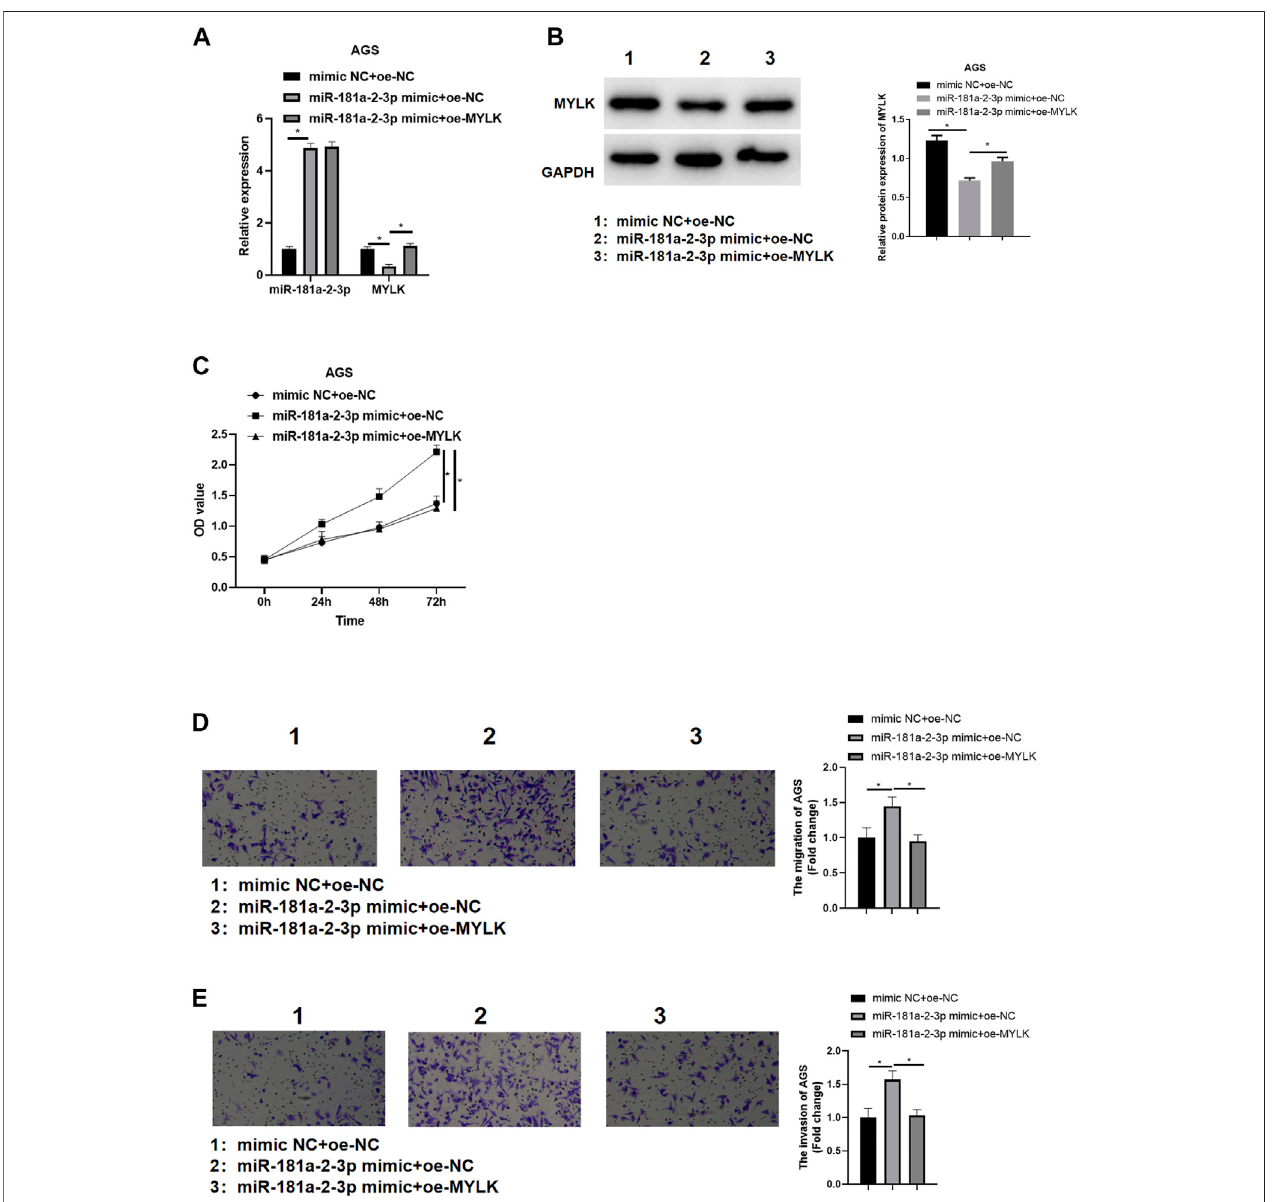
FIGURE 5 | miR-181a-2-3p promotes GC cell progression via hampering MYLK miR-181a-2-3p and MYLK were simultaneously overexpressed in AGS cells; (A) qRT-PCR and (B) western blot examined miR-181a-2-3p and MYLK; CCK-8 and Transwell (100 × ) determined cell (C) viability, (D) migration and (E) invasion of AGS cells; * p <